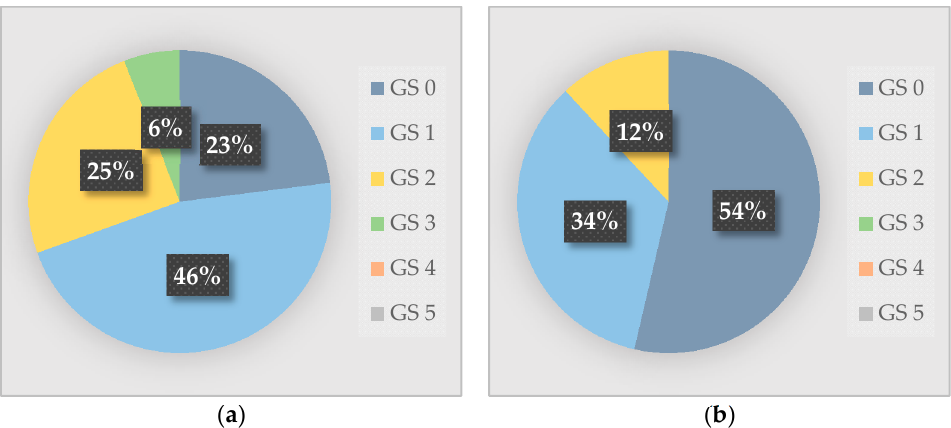
Figure 5. Proportion of chickens ( n = 300) with gait score (GS) 0–5 (Welfare Quality ® ) on six Swedish organic broiler farms: ( a ) Chickens scored indoors ( n = 149); ( b ) Chickens scored outdoors ( n = 151). Two farms were excluded for the comparison, as no birds were observed outdoors in these flocks.